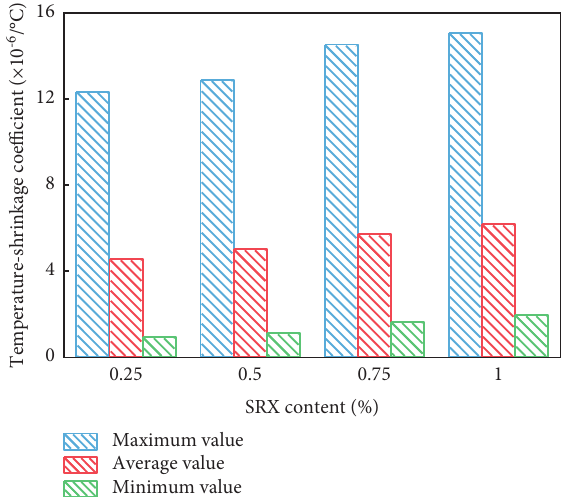
Figure 16: The change law of temperature shrinkage coefficient with the content of SRX stabilizer.